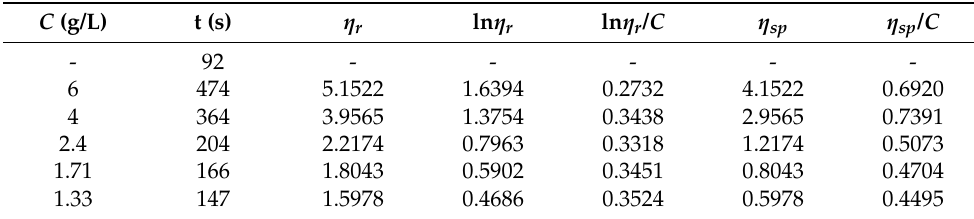
Table 2. Experimental data of CS.